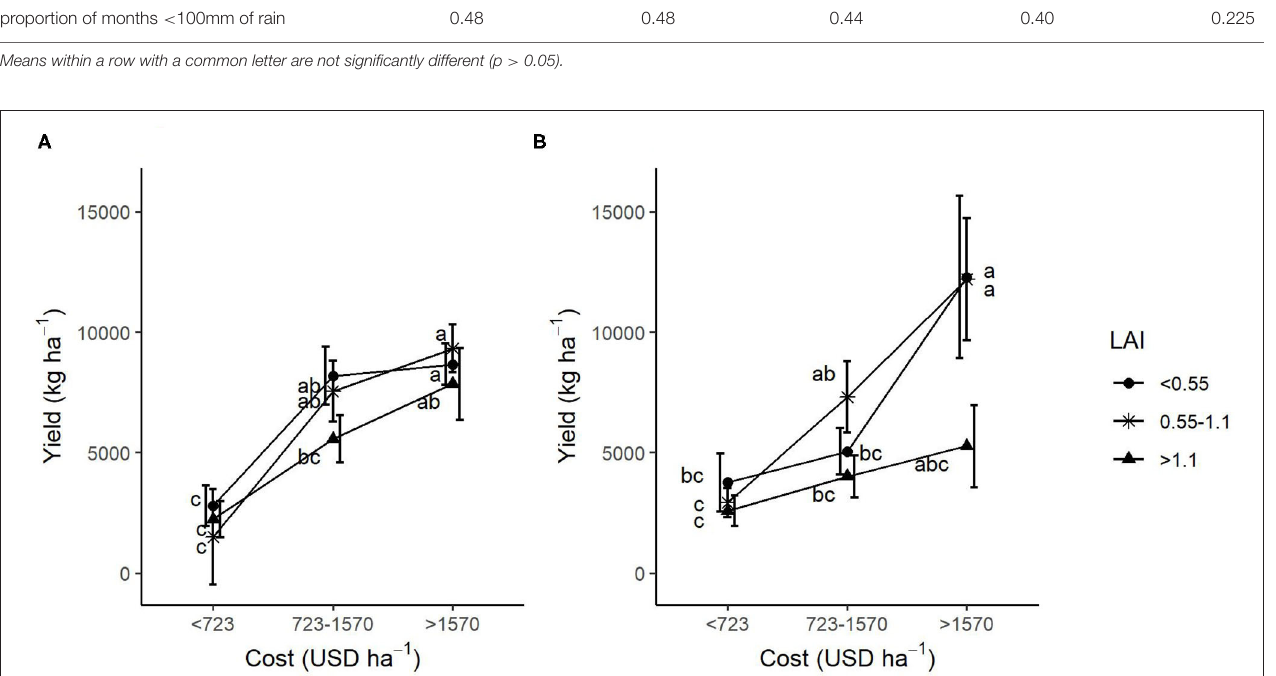
studies have found that ecosystem services from biodiversity such as pest regulation and pollination are affected by canopy cover and tree diversity (Martínez-Salinas et al., 2016; Chain- Guadarrama et al., 2019). Tree cover from shaded coffee may also contribute to landscape connectivity for groups such as birds, bats or amphibians (Murrieta-Galindo et al., 2013; Estrada- Carmona et al.,